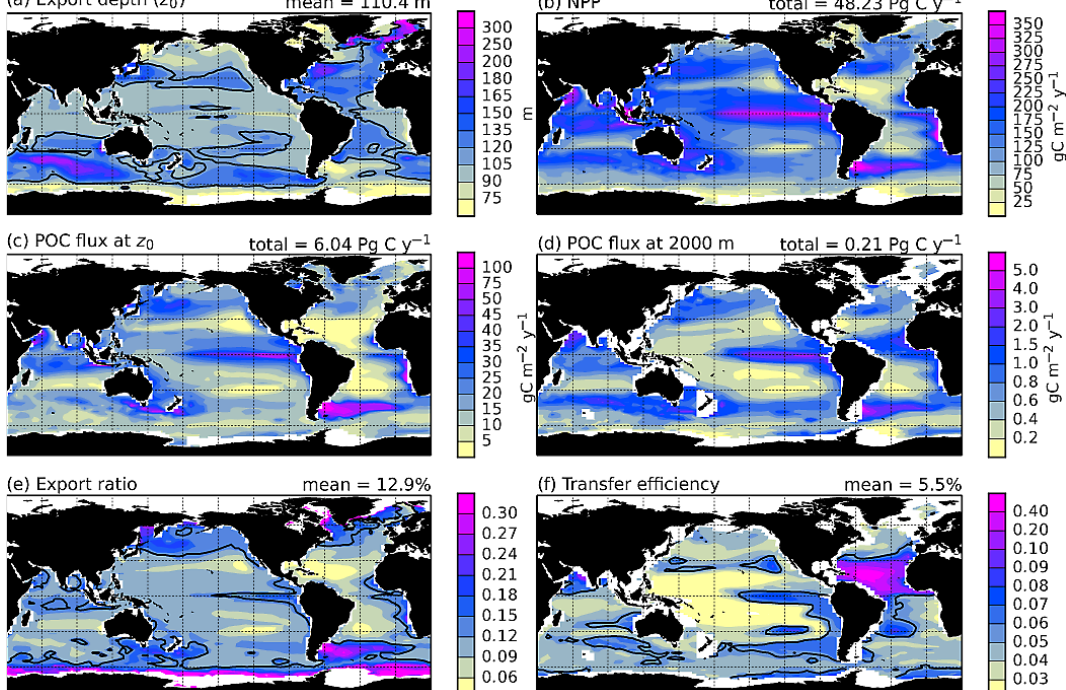
Fig. 4. CCSM–BEC annual mean export depth (a) , annual net primary production (NPP) (b) , POC flux at export depth (c) and 2000m (d) , export ratio (e) and transfer efficiency (f) . Export ratio (e) is defined as POC flux at export depth (c) divided by annual NPP (b) . Transfer efficiency (f) is defined as POC flux at 2000m (d) divided by POC flux at export depth (c) . Global integrals (NPP, POC flux at export depth and 2000m) and means (export depth, export ratio and transfer efficiency) are shown on the top right corner of the each panel. The solid black lines in (a) , (e) and (f) denote the contour for the global mean